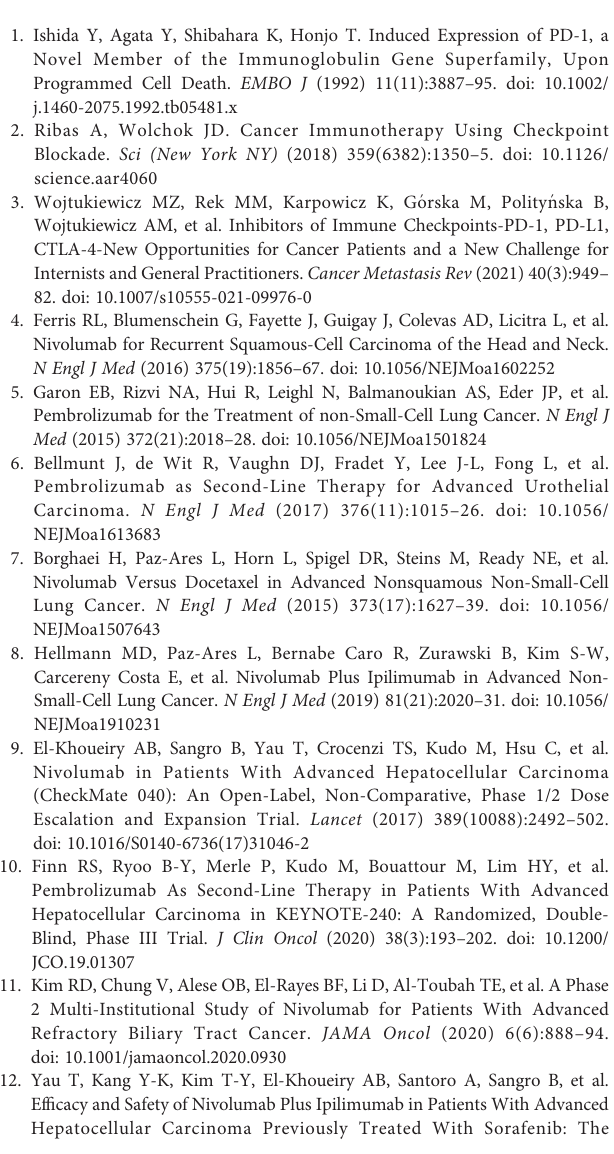
bilirubin; aminotransferase; CHE, cholinesterase; LDH, lactate dehydrogenase; PTA, prothrombin activity; WBC, white blood cell; ANC, absolute neutrophil count; LYM, absolute lymphocytes; AMC, absolute monocyte count; PLT, platelets; NLR, neutrophil-lymphocyte ratio; PLR, platelet -lymphocyte ratio; PWR, platelet-white blood cell ratio. Supplementary Table 3 | Univariate binary logistic regression analysis for risk factors of all grade and grade3/grade4 irAEs. BCLC, Barcelona Clinic Liver Cancer; M, metastasis; PVTT, portal vein tumor thrombus; TACE, transcatheter arterial chemoembolization; CRP, C-reactive protein; IL-6, interleukin-6;AFP, Alpha ‐ Fetoprotein;ALB, albumin; TBIL, totalbilirubin;ALT, alanineaminotransferase; AST, aspartate aminotransferase; CHE, cholinesterase; LDH, lactate